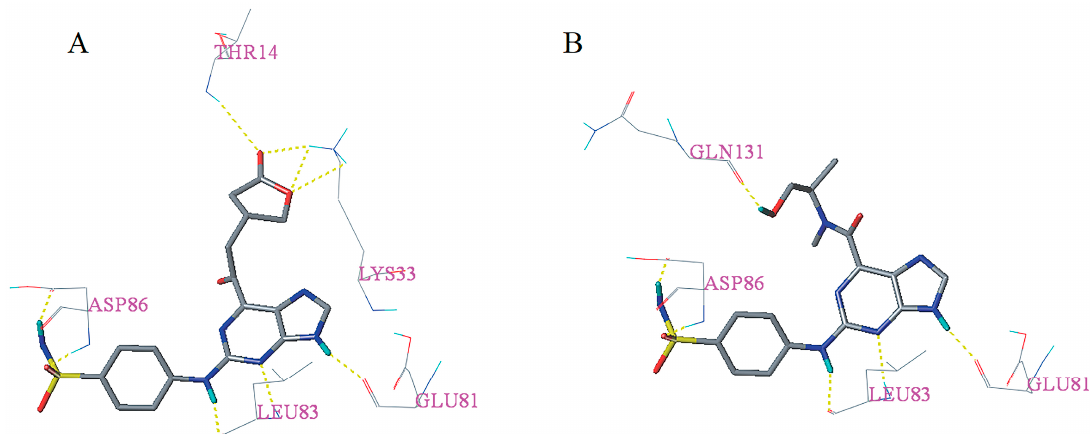
Figure 6. Docking results of candidate compounds I13 ( A ) and I60 ( B ). Hydrogen bonds were shown as yellow dashed lines and non-polar hydrogens were removed for clarity.